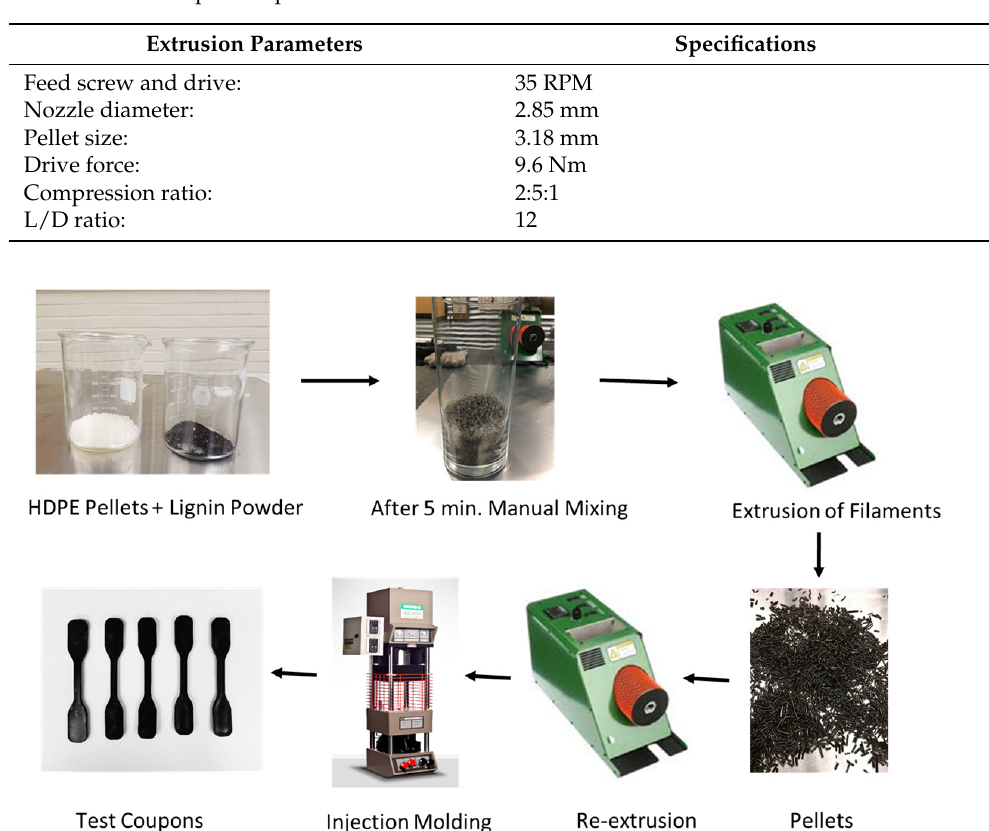
Table 1. Extrusion process parameters.